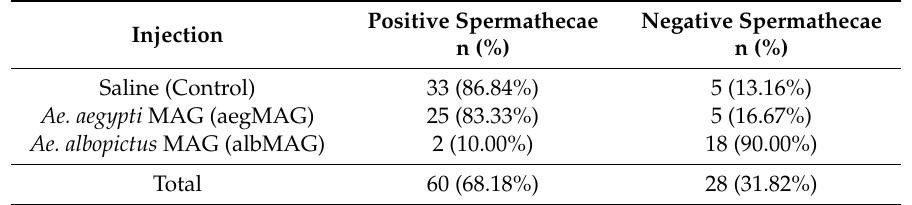
Table 3. Number and percentage of positive and negative dissected spermathecae of Aedes albopictus females injected with saline (control), accessory glands MAGs of Ae. aegypti and MAGs of Aedes albopictus and exposed to conspecific males for 48 h.